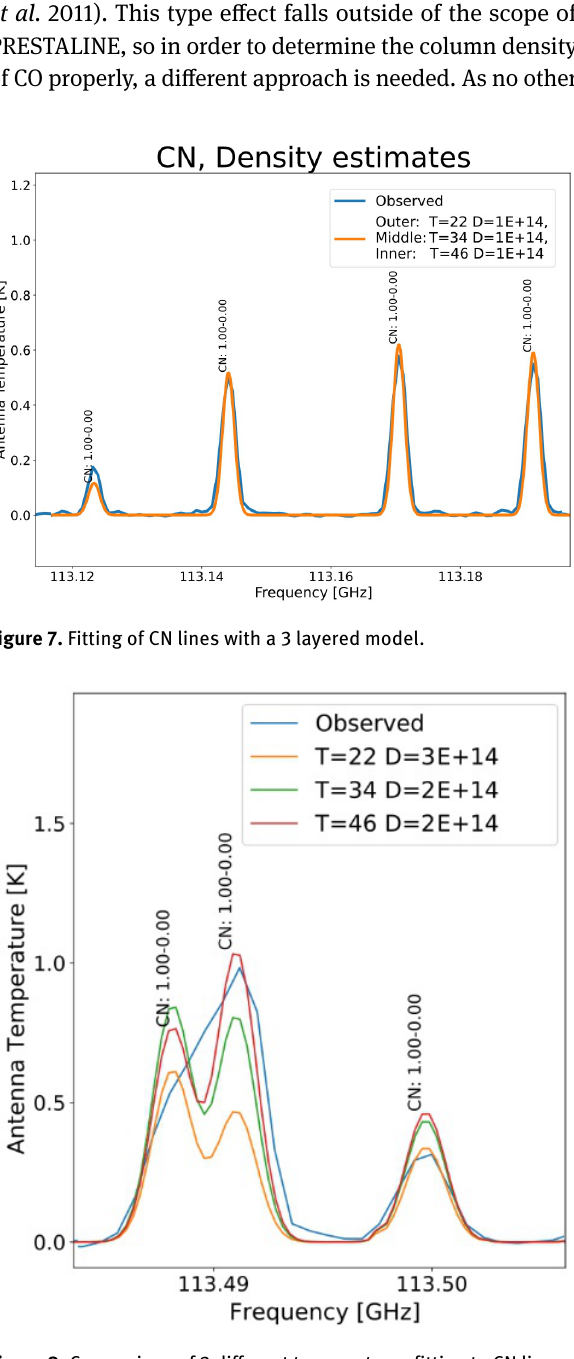
Figure 8. Comparison of 3 different temperatures fitting to CN lines.